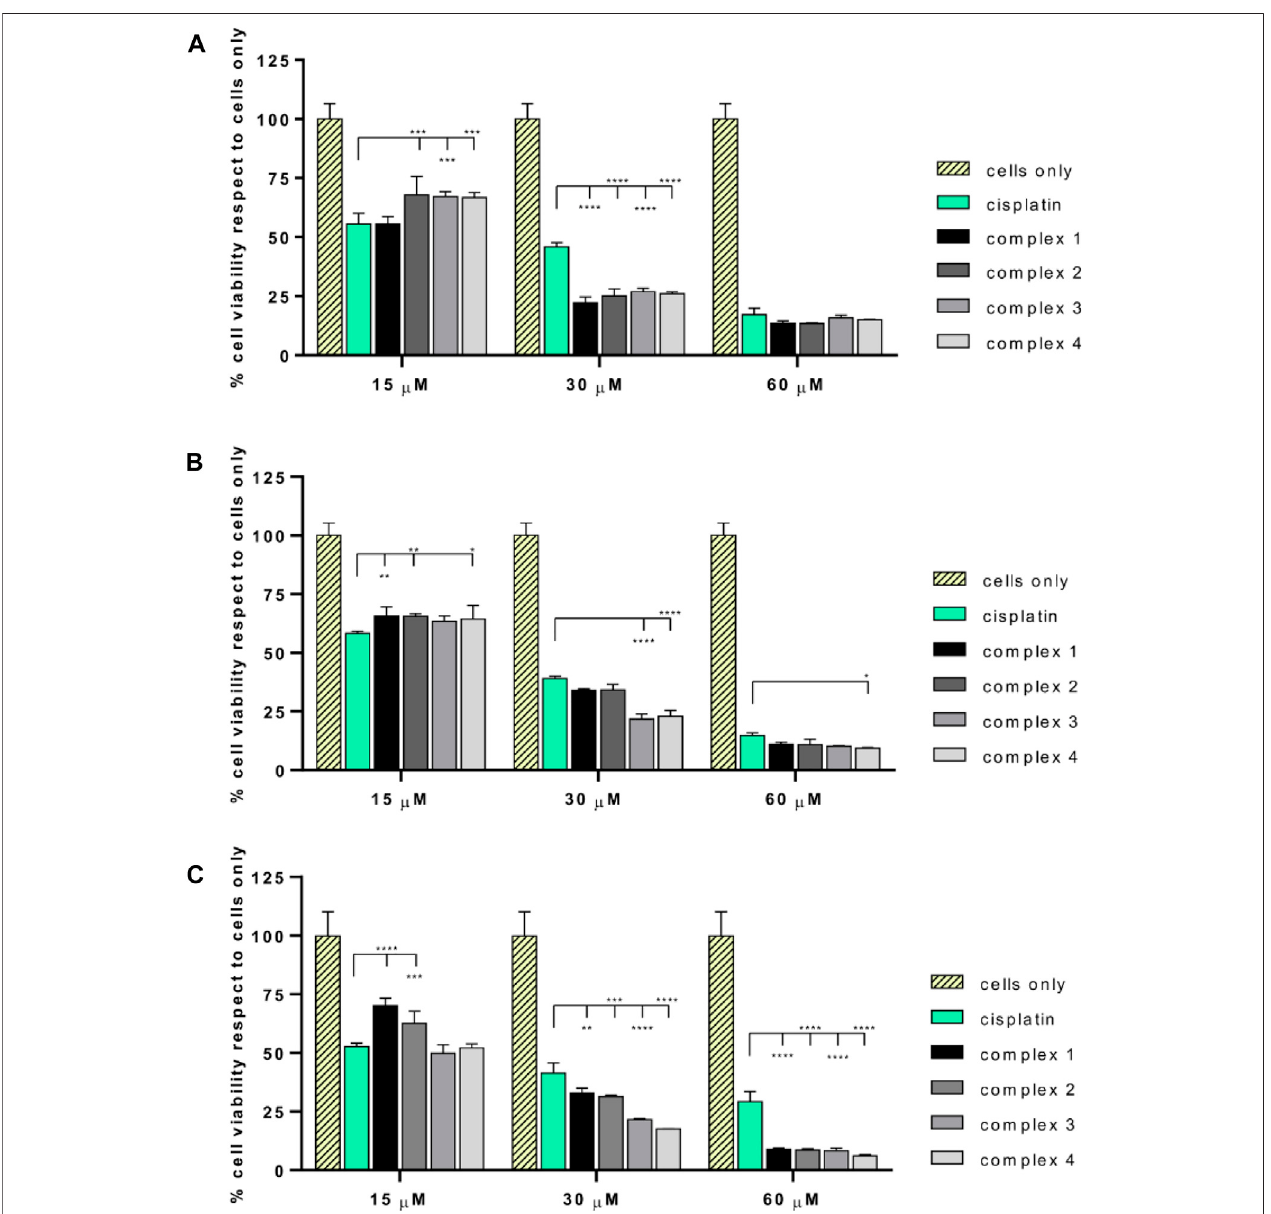
FIGURE3| MTTassayofSAOS-2,U-2OS,andMG63 . Percentageofcellviability(mean ± SEM)respecttocellsonlyisreportedinthegraphsforSAOS-2 (A) ,U-2 OS (B) andMG63 (C) after72 hofdrugexposure.Statisticallysigni fi cantdifferencesrespecttocisplatinarereportedinthegraphs(* p value ≤ 0.05,** p value ≤ 0.01,*** p value ≤ 0.001, **** p value ≤